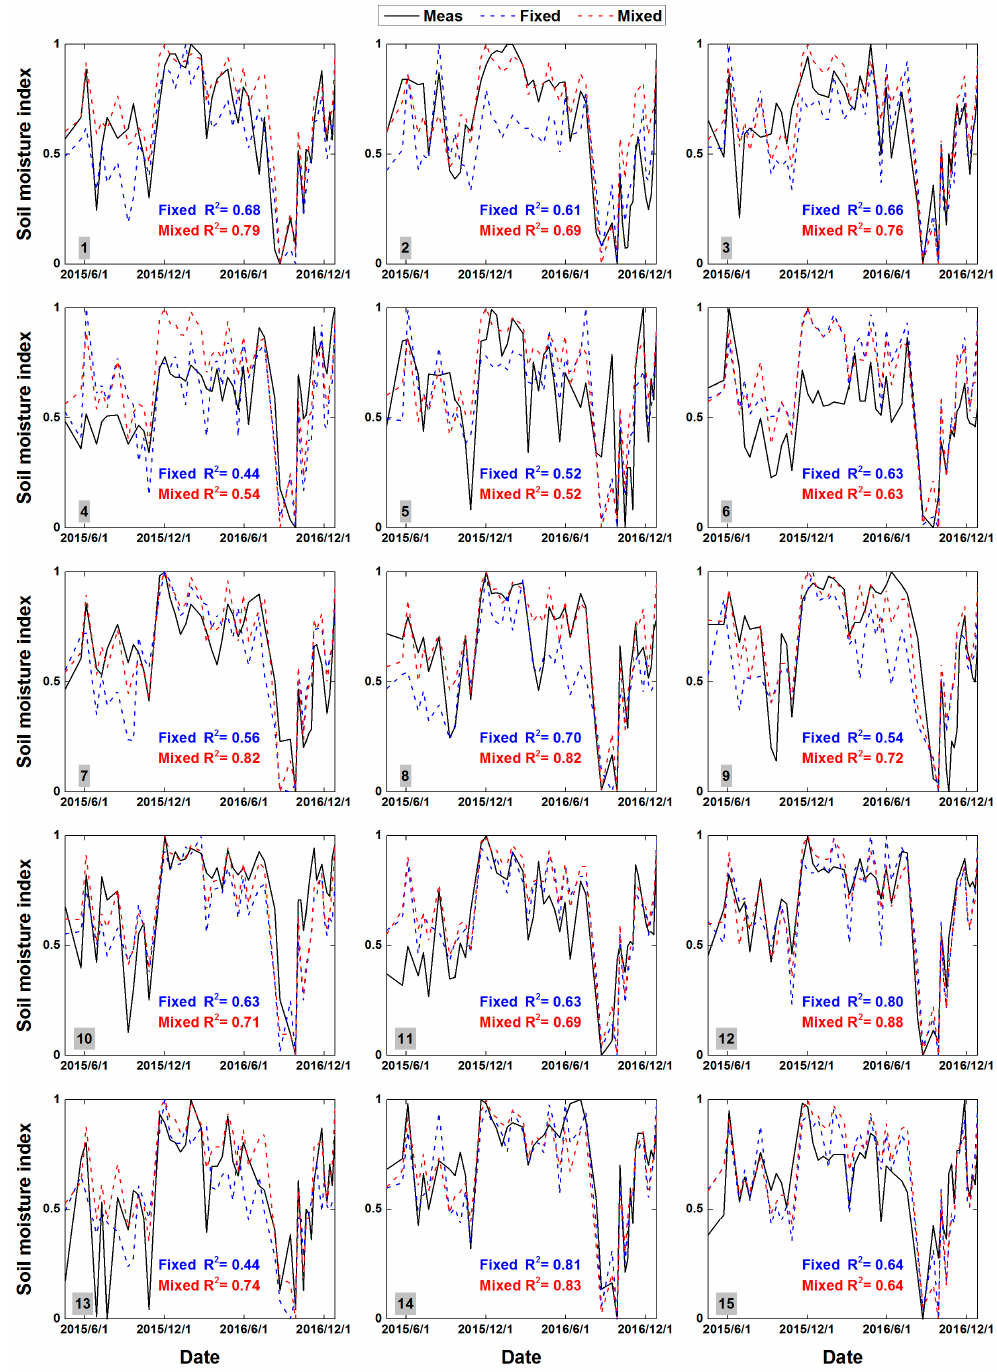
Figure 4. Measured (black solid lines) and predicted soil moisture indices of 15 observation sites, with the blue dash lines predicted by the linear fixed effects model and the red dash lines predicted by the LME model. Number in lower left corner for each subplot denotes site ID.